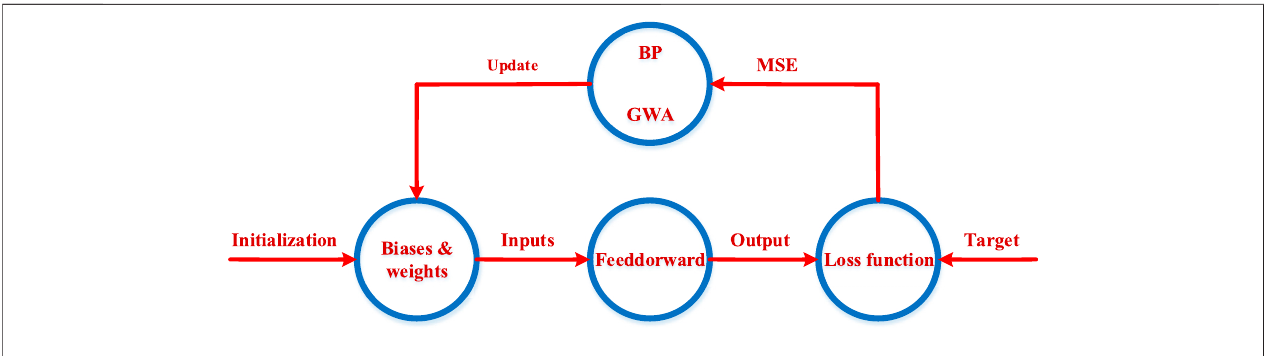
FIGURE 3 | Training method of the MLP.